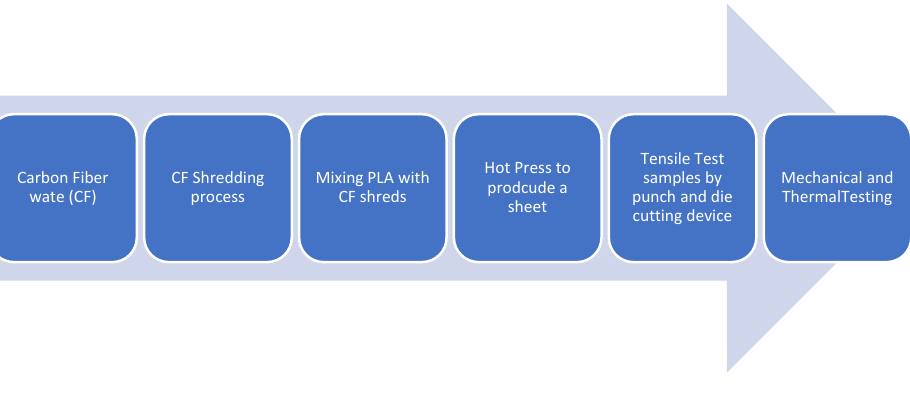
Figure 8. Formation of PLA/CF composite.